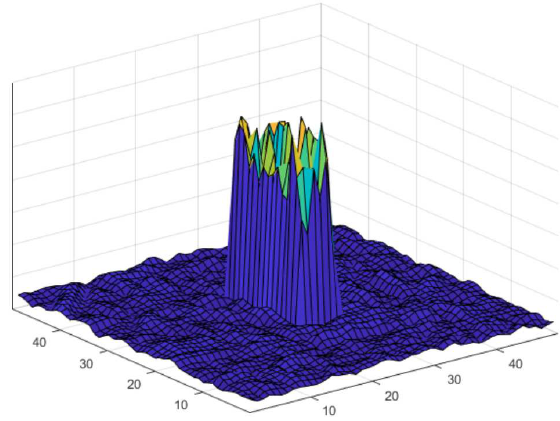
Figure 4. Visualization of the filter coefficients of